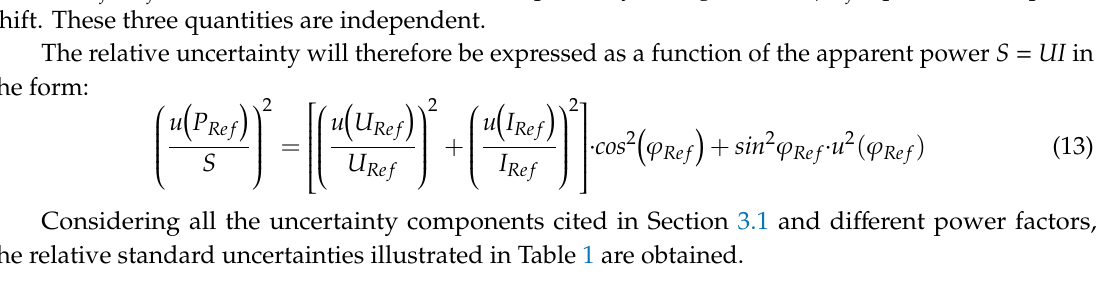
Table 1. Relative standard uncertainties for 25 kV, 50 Hz and 400 A, 50 Hz sinusoidal signals. cos ( ϕ Ref